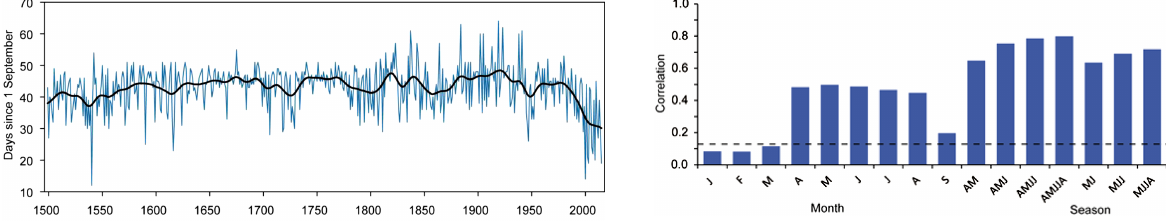
Figure 3. Fluctuations in median grape-harvest day (in days from 1 September) for the Bohemian wine-growing region in the 1499– 2015 period. Smoothed by Gaussian filter over 30 years.